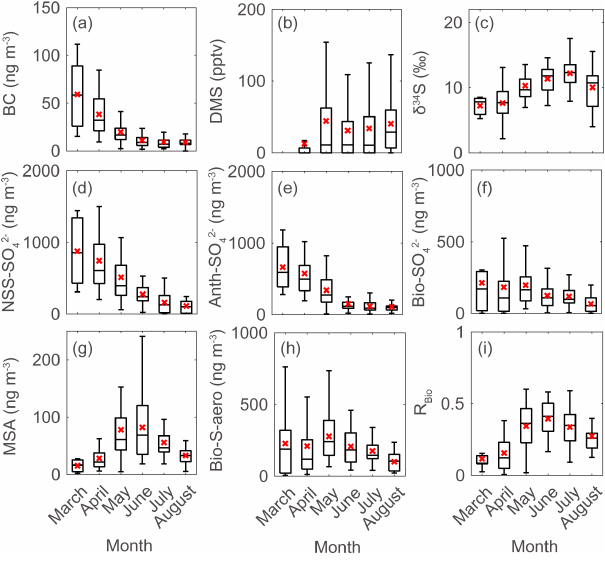
Figure 3. Monthly data during the measurement years (2015–2019) for (a) black carbon (BC), (b) atmospheric DMS mixing ratio, (c) sulfur isotope measurements ( δ 34 S), (d) NSS-SO 2 − , (e) Anth- 4 SO 2 − , (f) Bio-SO 2 − , (g) MSA, (h) Bio-S-aerosol, and (i) MSA- 4 4 to-Bio-S-aerosol ratio ( R Bio ) during the measurement years (2015– 2019). Solid lines and red crosses represent the median and mean values of the data,